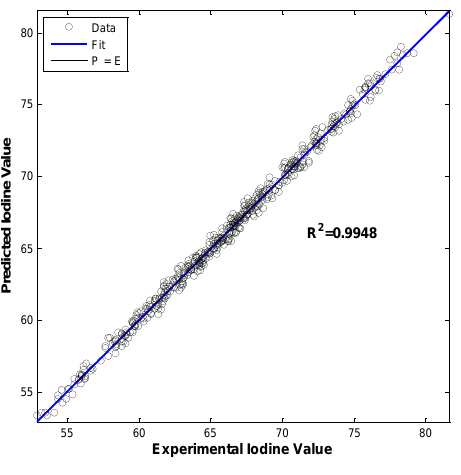
Fig. 3 Predicted Iodine value vs. experimental iodine value for the test set (500